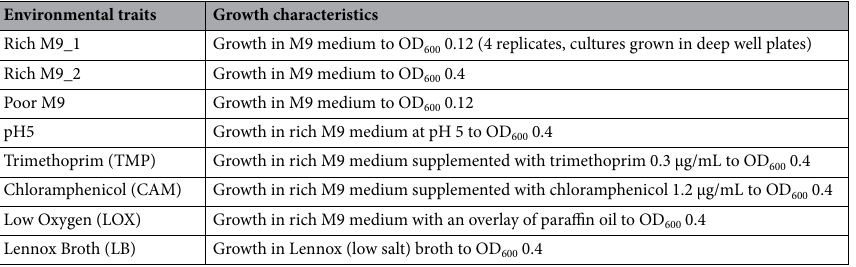
Table 1. Growth conditions representing stress encountered by E. coli. Rich M9: 1 × M9 salts, 1% CAA, 0.4% glucose, 2 mM